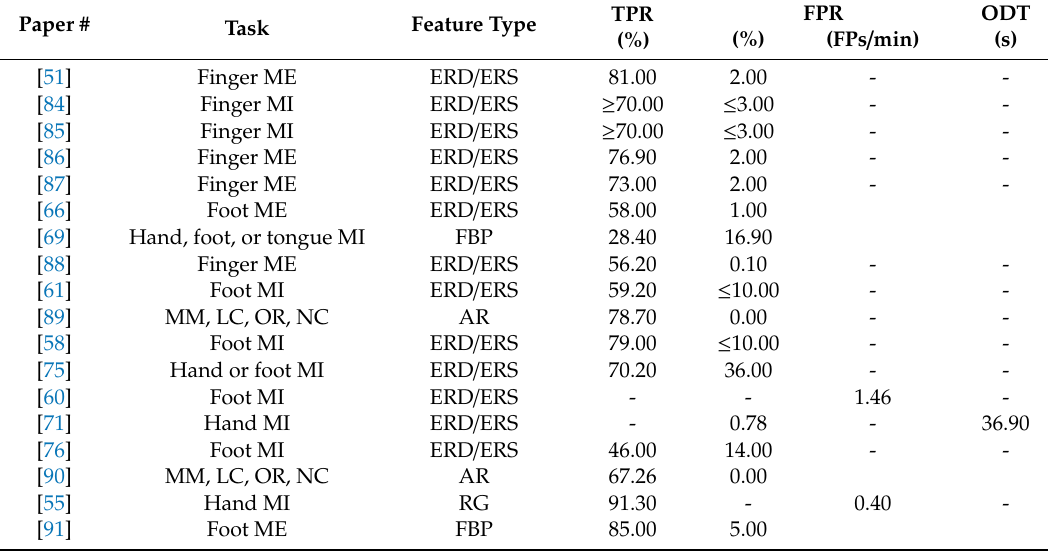
Table 3. List of electroencephalography (EEG)-based endogenous brain-switches. Note that eight papers [52,67,68,72,73,77,92,95] did not report true positive rate (TPR) and false positive rate